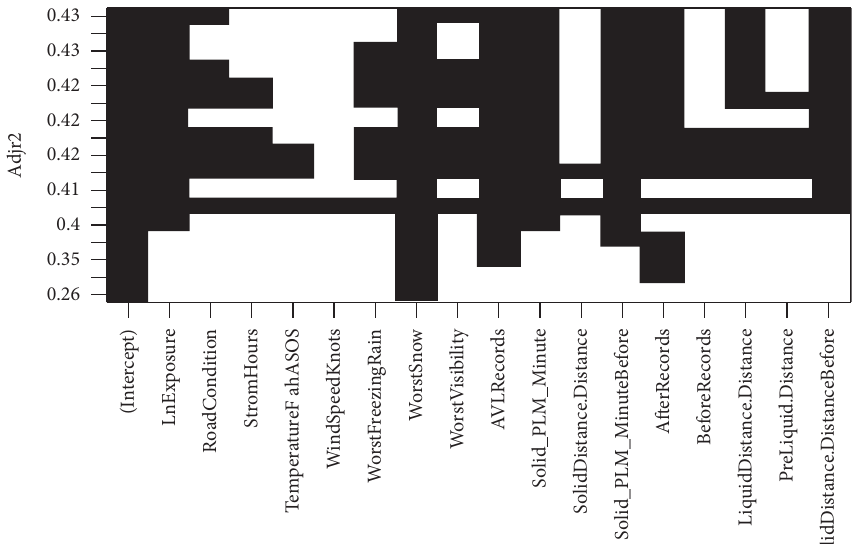
Figure 7: Adjusted R 2 exhaustive search output.